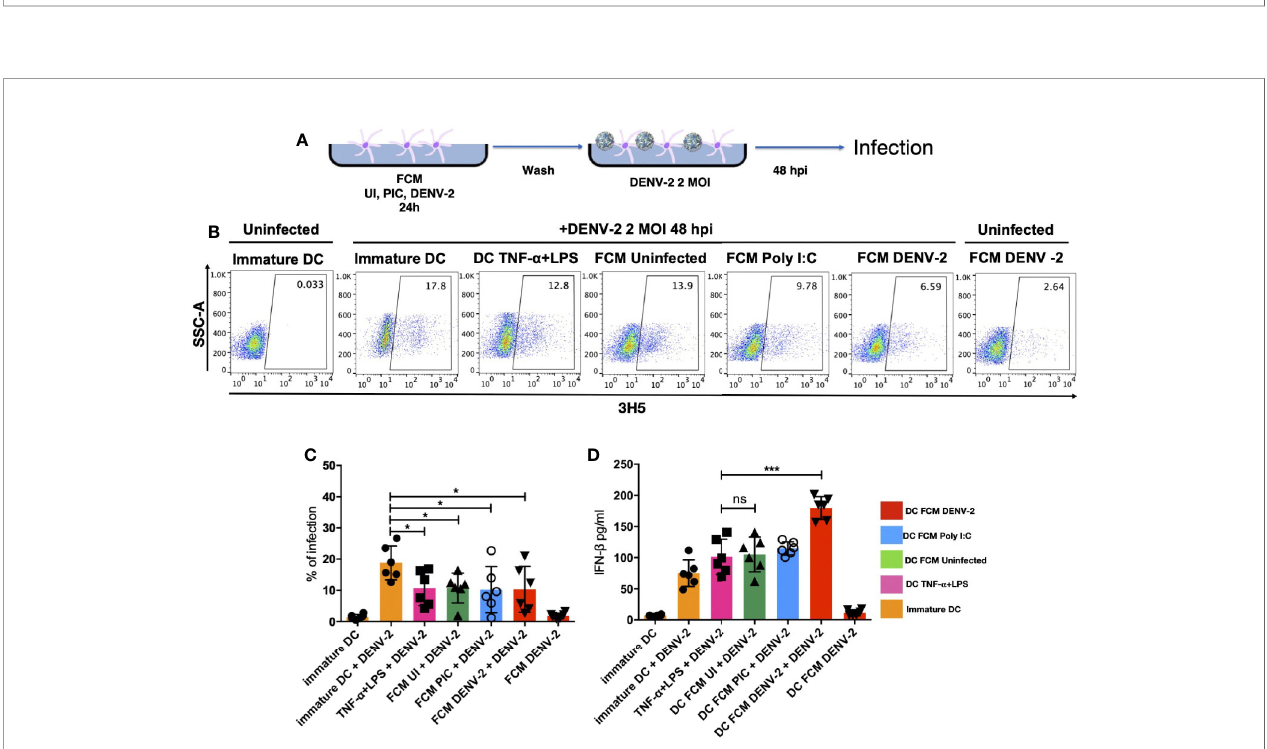
FIGURE 3 | DENV-2 infection is inhibited in fi broblast-matured moDC. moDCs treated with all three FCM for 24 hours were washed and infected with DENV-2 at 2 MOI for 48 hours. The infection rate was assessed with intracellular staining using fl ow cytometry. (A) Schematic representation of the maturation and infection of moDCs. (B) Representative dot plot from one donor where DENV-2 infection rate was observed. (C) Percentage of infection among all donors as measured using fl ow cytometry, which assessed the expression of the viral envelope protein. (D) IFN- b secretion by fi broblast-matured moDC that were infected with DENV-2, as measured using ELISA. Error bars indicate the standard deviations for the three independent experiments of each donor; n = 6. ns, no signi fi cant. *P < 0.05 and ***P <